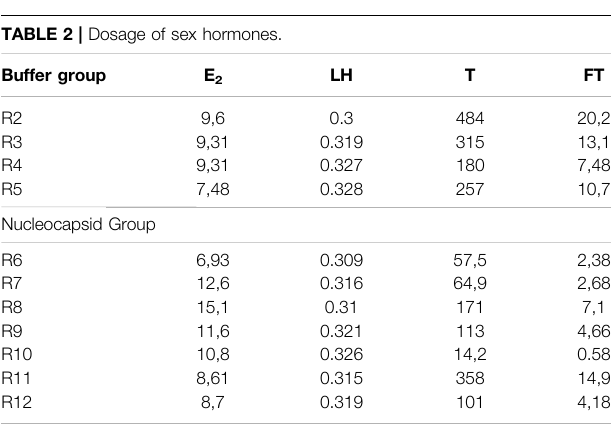
TABLE 2 | Dosage of sex hormones.